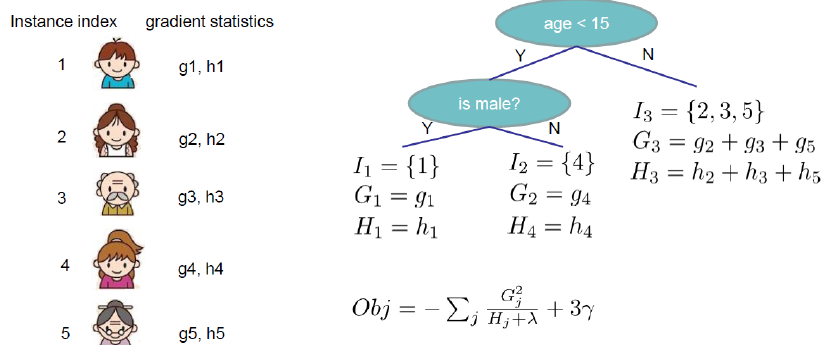
Figure A2. Structure score calculation. Source: Chen and Guestrin (2016).